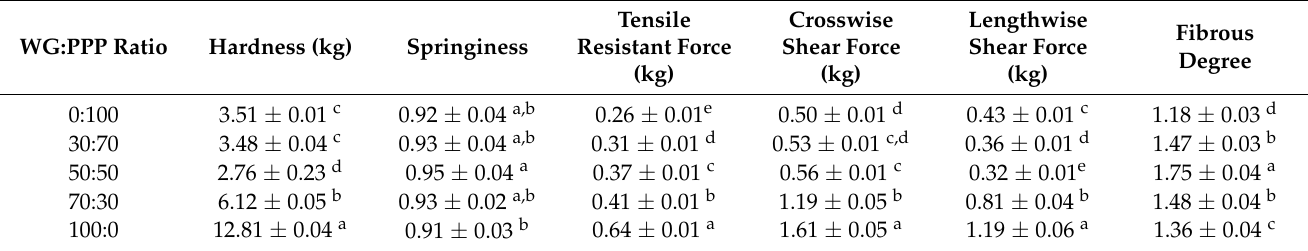
Table 8. Texture properties of extrudates with different mixing